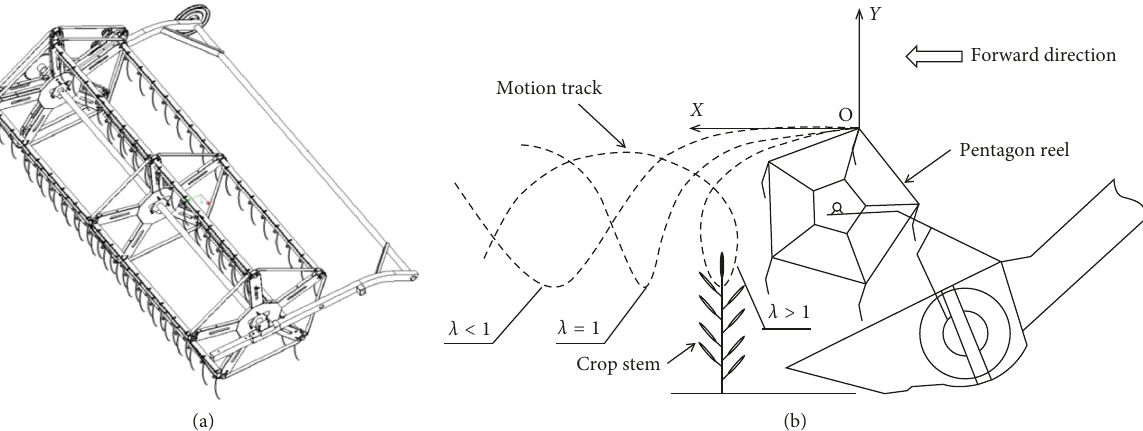
Figure 2: Structure and schematic of the pentagon reel. (a) Assembly of the pentagon reel. (b) Trajectory of the pentagon